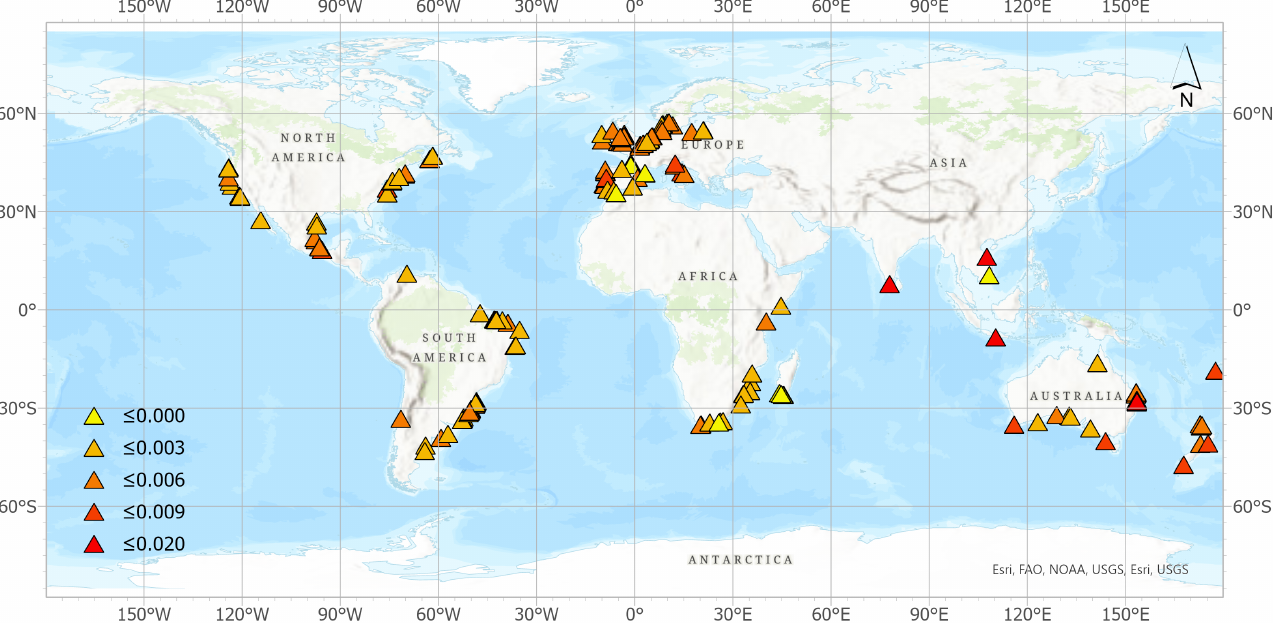
Figure 5. Sen’s slope (per year) based on the trend component of the NDVI series. Only sites with a statistically significant nonzero slope are shown. Positive slopes are split into classes that correspond to slowly increasing (0 < Q NDVI ≤ 0.003 per year); moderately increasing (0.003 < Q NDVI ≤ 0.006 per year); rapidly increasing (0.006 < Q NDVI ≤ 0.009 per year); and (4) very strongly increasing ( Q NDVI > 0.009 per year)